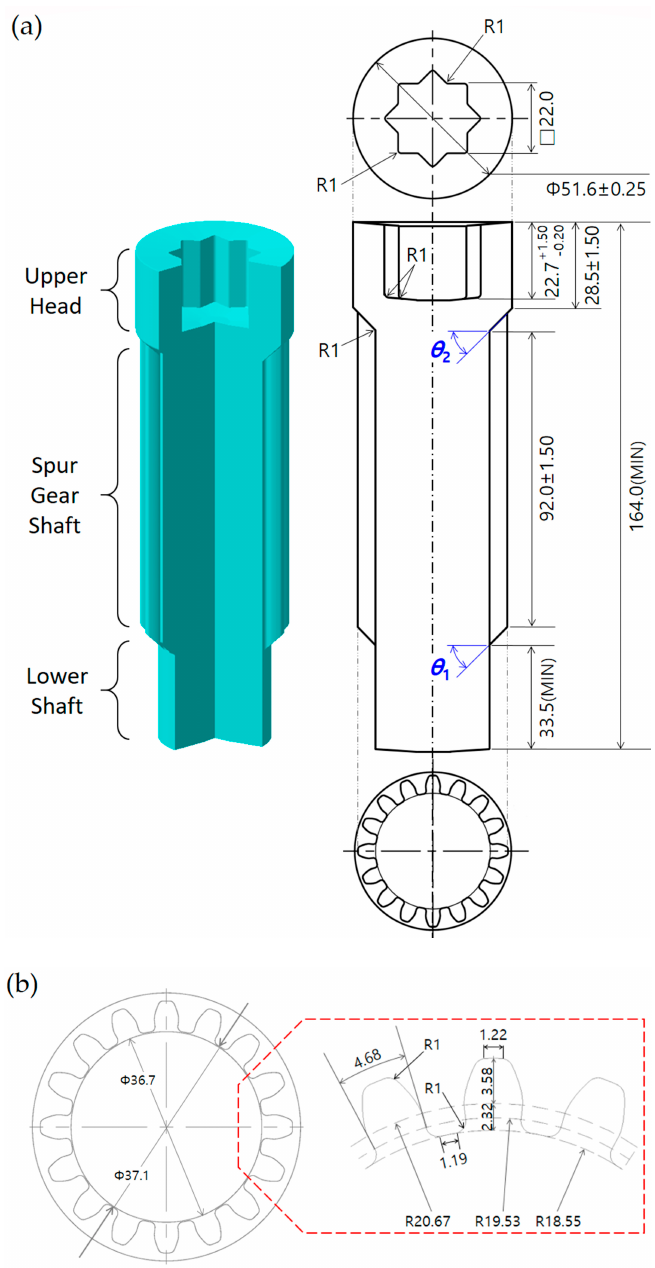
Figure 1. Schematic views and layout of the drive shaft (unit: mm): ( a ) three-dimensional configuration and layout of the drive shaft; ( b ) cross-sectional layout of the spur gear.